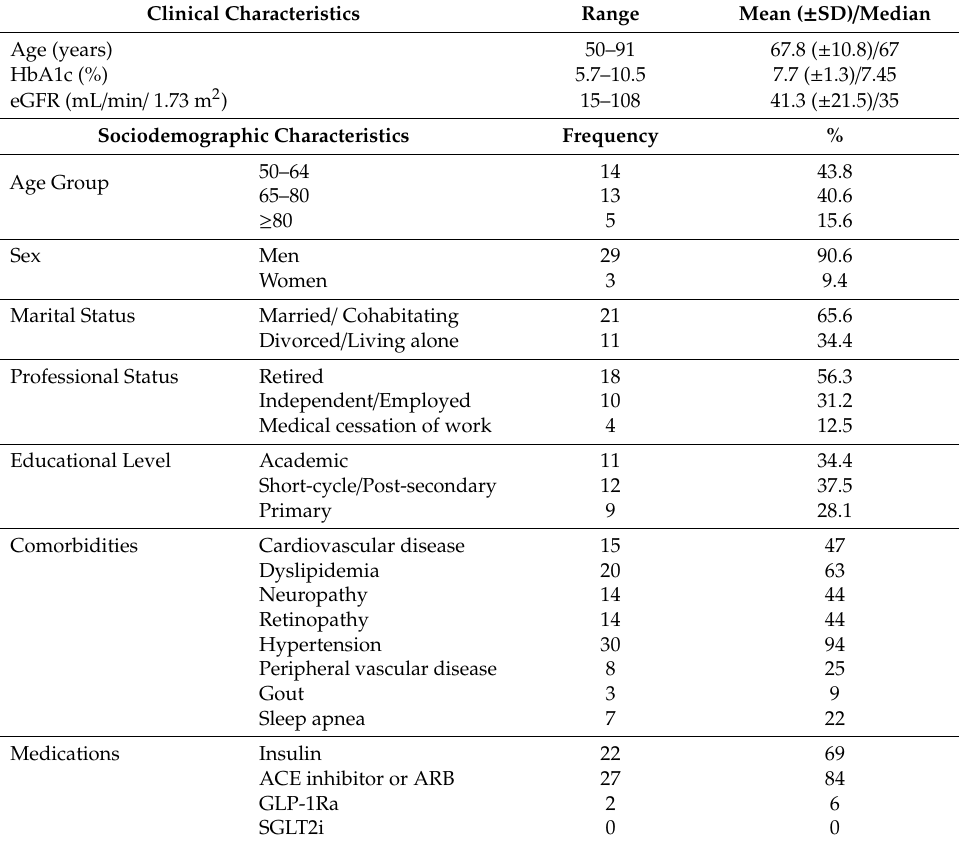
Table 3. Characteristics of Study Participants ( n =